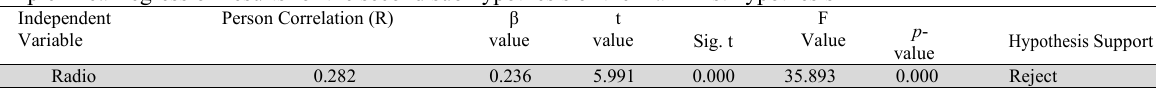
Simple linear regression results for the second sub hypothesis of the main first hypothesis Independent Variable